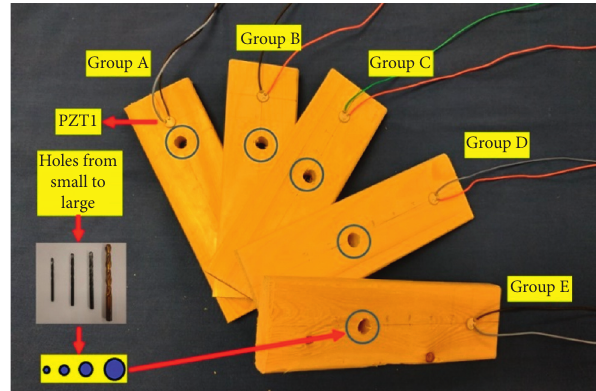
Figure 2: Timber specimens with holes.